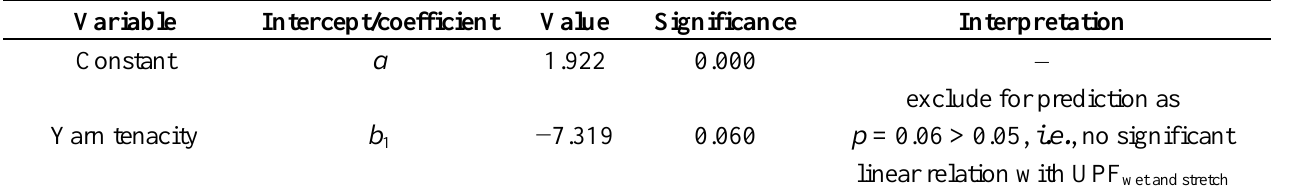
Table 6. Coefficient table for model predicting UPF